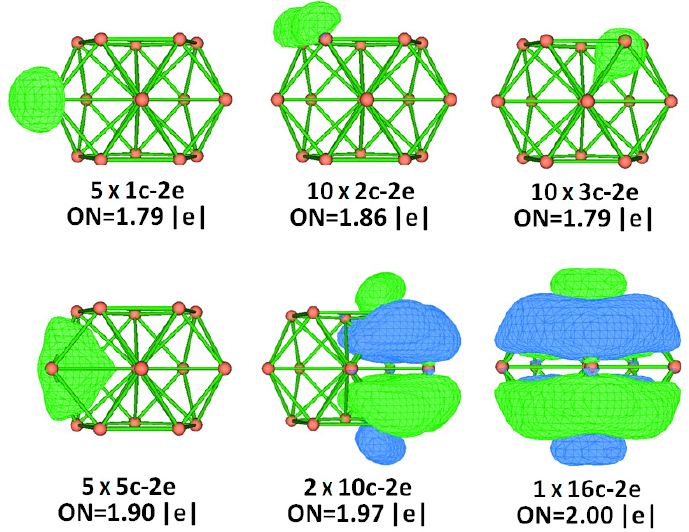
Figure 6. AdNDP analysis of ZrSi 152- cluster. ON stands for the occupation number.